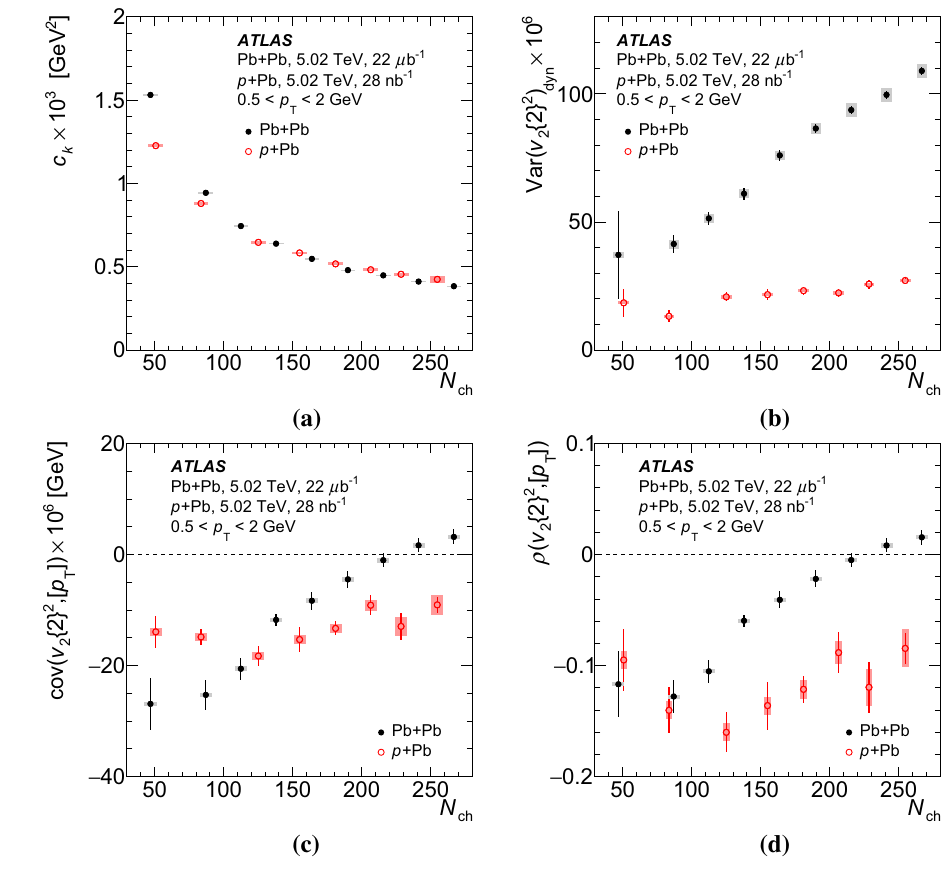
Fig. 6 Comparison of a c k , b (cid:4) (cid:3) v { 2 } 2 Var , c 2 dyn cov (v 2 { 2 } 2 , [ p T ] ) , and the d ρ(v { 2 } 2 , [ p ] ) for the range 2 T 0 . 5 < p T < 2 GeV as a function of the charged-particle multiplicity N ch . The statistical and systematic uncertainties are shown as vertical error bars and boxes,